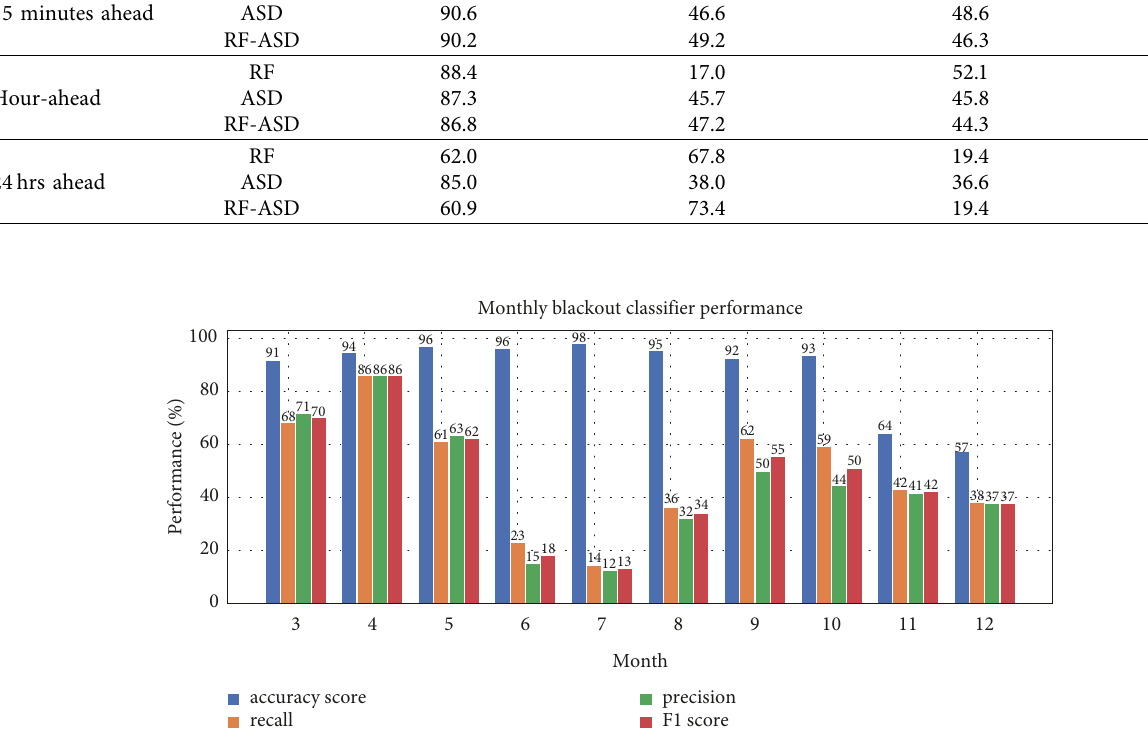
Figure 8: Monthly blackout forecast performance for 15-minutes ahead RF-ASD classifier